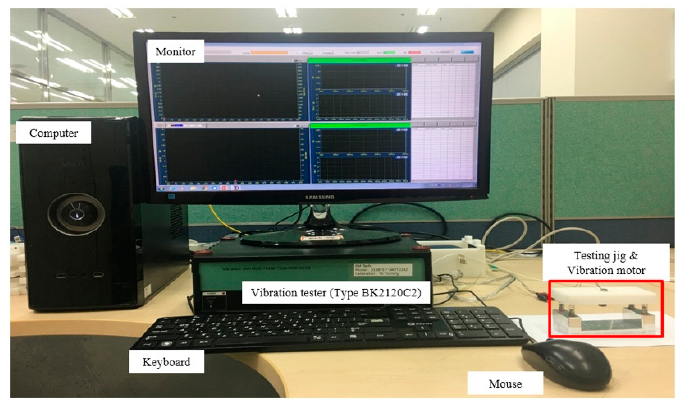
Figure 13. The acceleration measurement setup under standard test conditions.